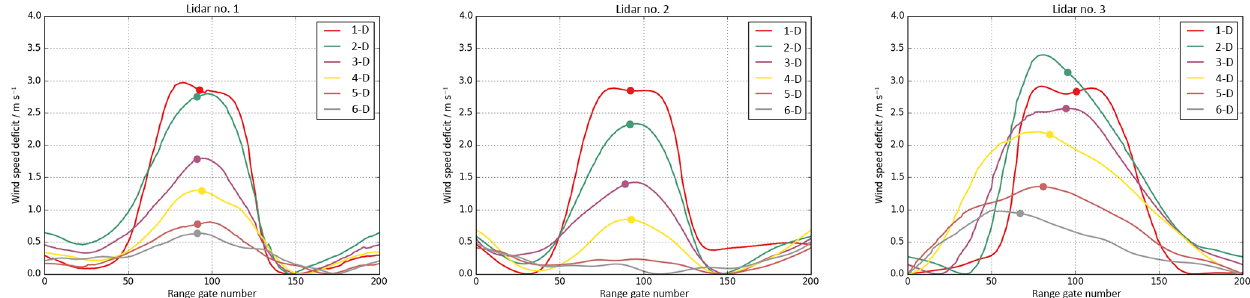
Figure 11. Averaged line-of-sight measurements through the wake by the three lidar systems at different distances to the wind turbine. The dots show the estimated wake center positions by a Gaussian